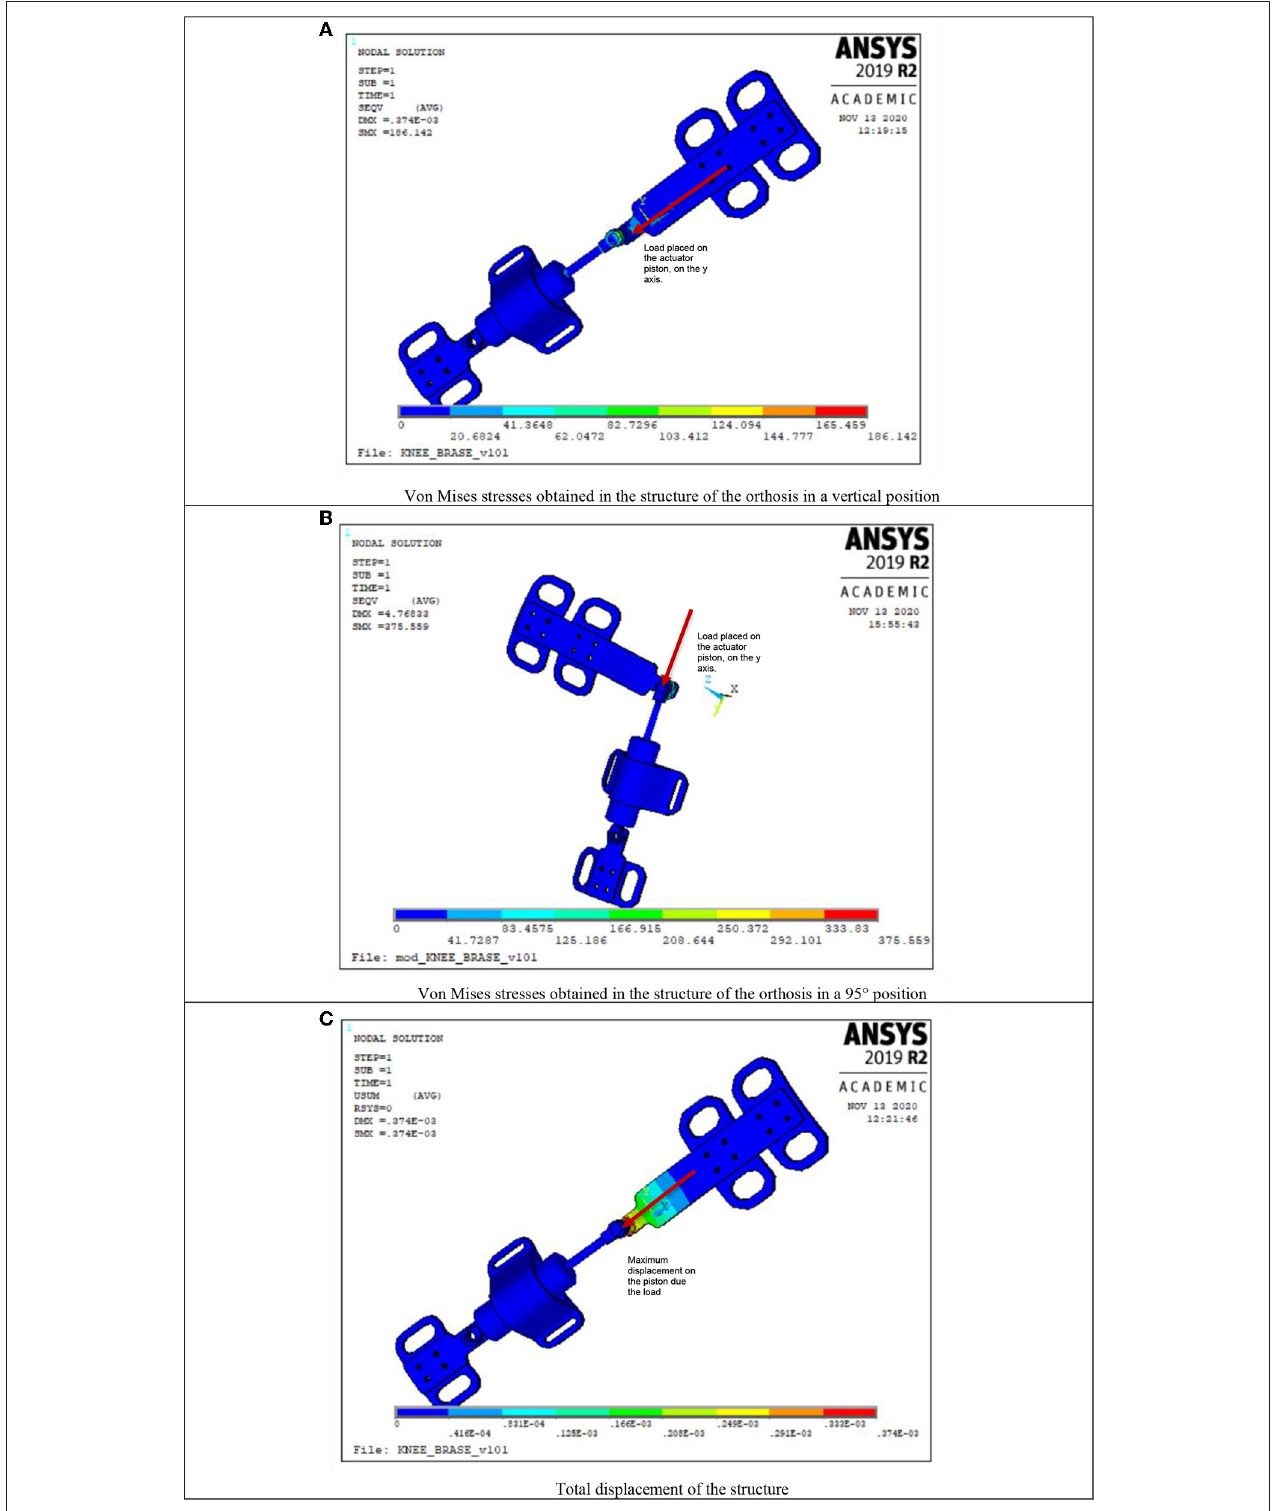
FIGURE 13 | Stress analysis on ANSYS ® . (A) Von Mises stresses obtained in the structure of the orthosis in a vertical position. (B) Von Mises stresses obtained in the structure of the orthosis in a 95 ◦ position. (C) Total displacement of the structure.